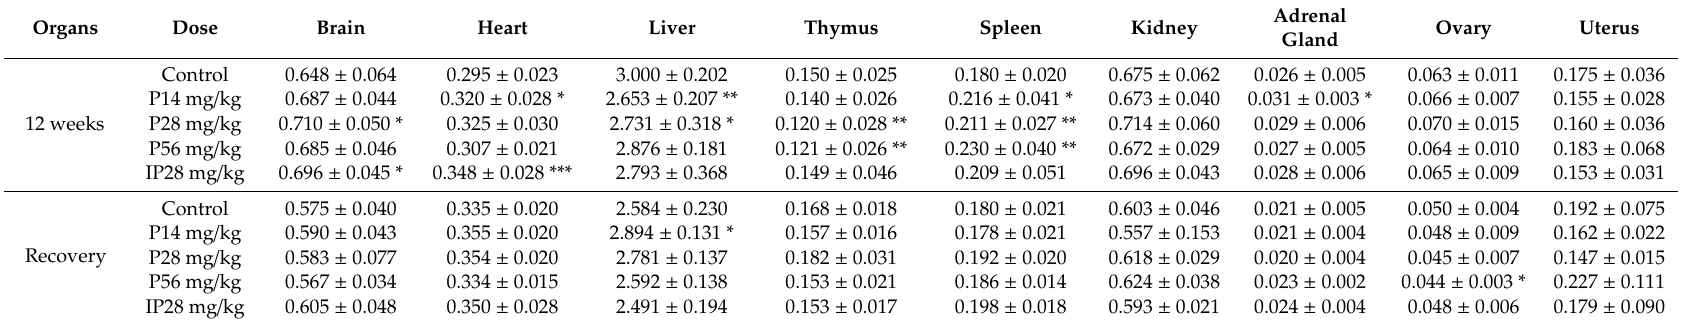
Table 1. Visceral coe ffi cients of rats after 3 months of repeated administration and 4 weeks of recovery, respectively (mean ± SD, n = 12 for administration and n = 6 for recovery).